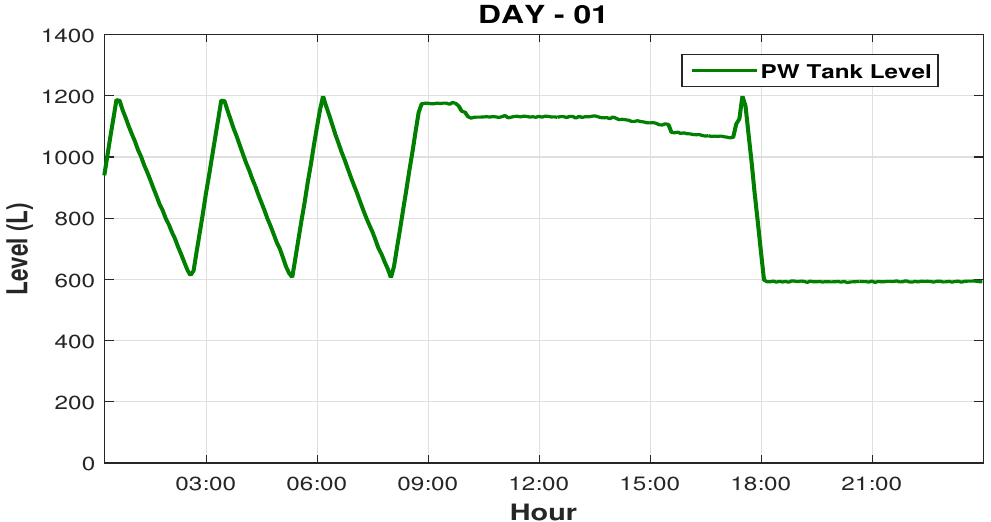
Figure 17. Sketch of graphical PW level reads during an